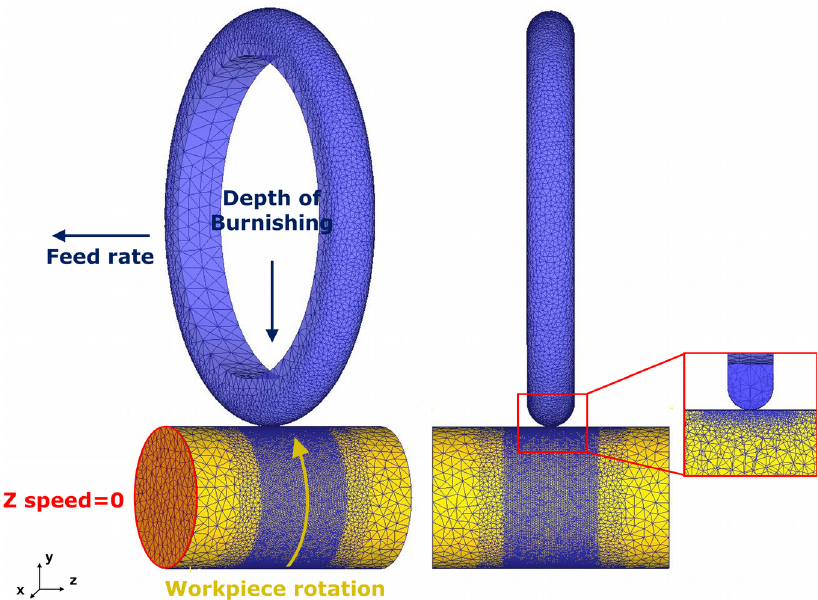
Figure 4. Numerical model movement setup, boundary conditions and mesh (Sanguedolce et al.,